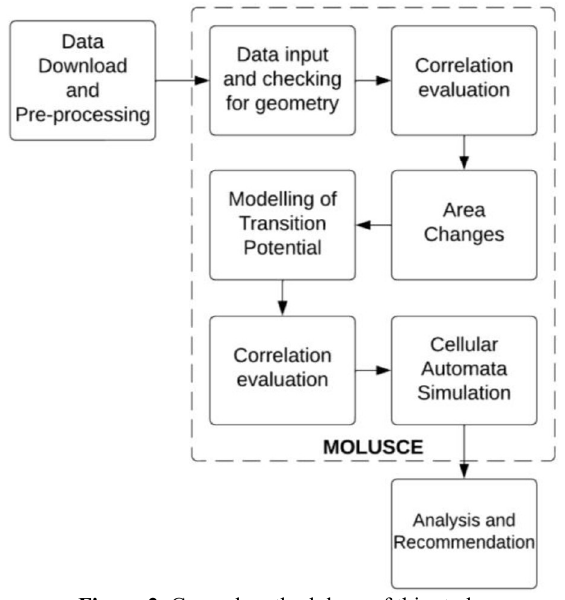
Figure 2. General methodology of this study.